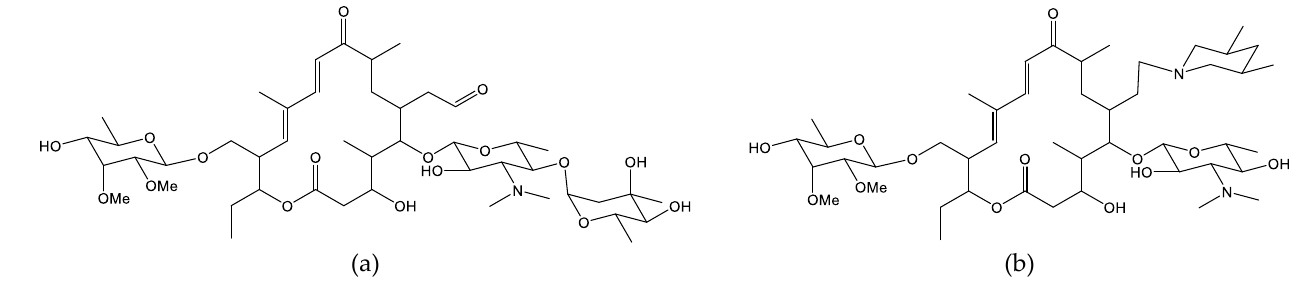
Scheme 1. Chemical structure of the main component of ( a ) tylosin, tylosin A and ( b )